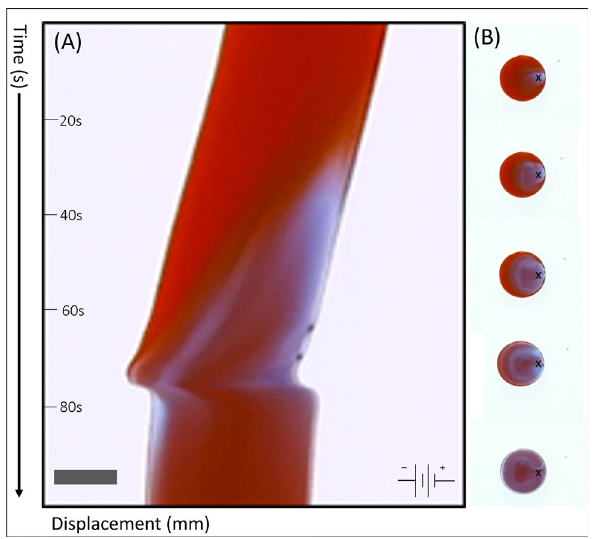
Figure 2. Motion of the droplet driven by the chemical wave. ( A ) Kymograph demonstrating the spatial and temporal pattern of chemical wave propagation in a BZ droplet. The electric field is in the horizontal direction pointing to the left. The scale bar represents 2 mm. The total time duration was 100 s. ( B ) Time-lapse images of the droplet at the sampling rate of 10 s. The location of the leading center is marked with an ’x’. The wave propagation can be seen from the color changes in the